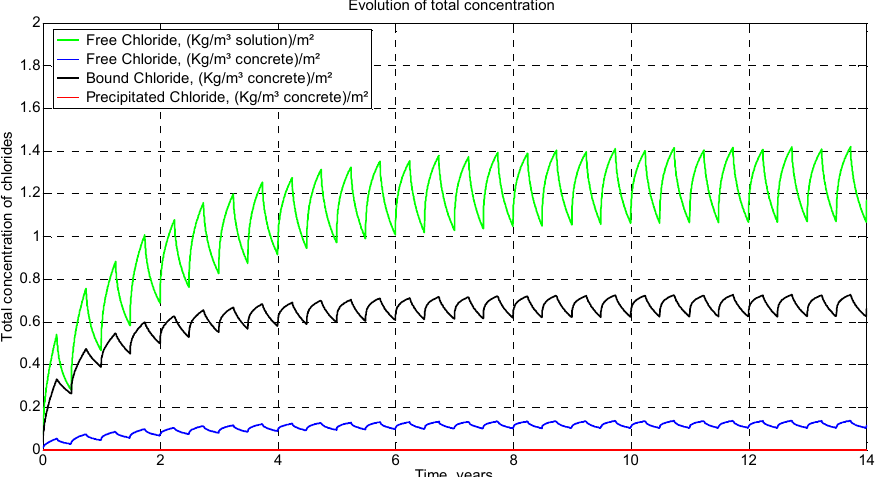
Figure 22. Time dependent of total chloride of C f,s (free chloride in kg/m 3 solution), C f,c (free chloride in kg/m 3 concrete), C b (bound chloride in kg/m 3 solution) and C p (precipitated chloride in kg/m 3 concrete) that penetrates the boundary.